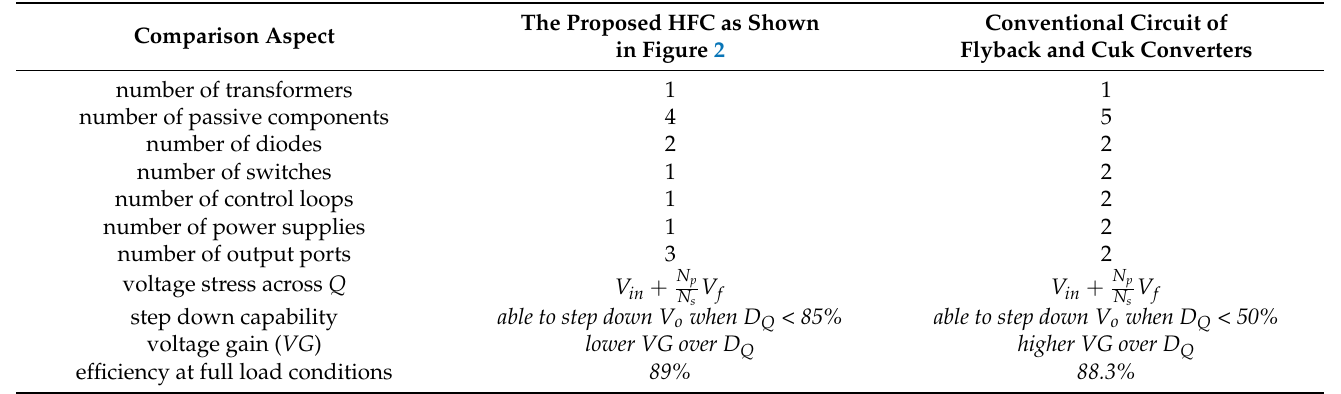
Table 3. Summary of different comparison aspects between HFC and a conventional